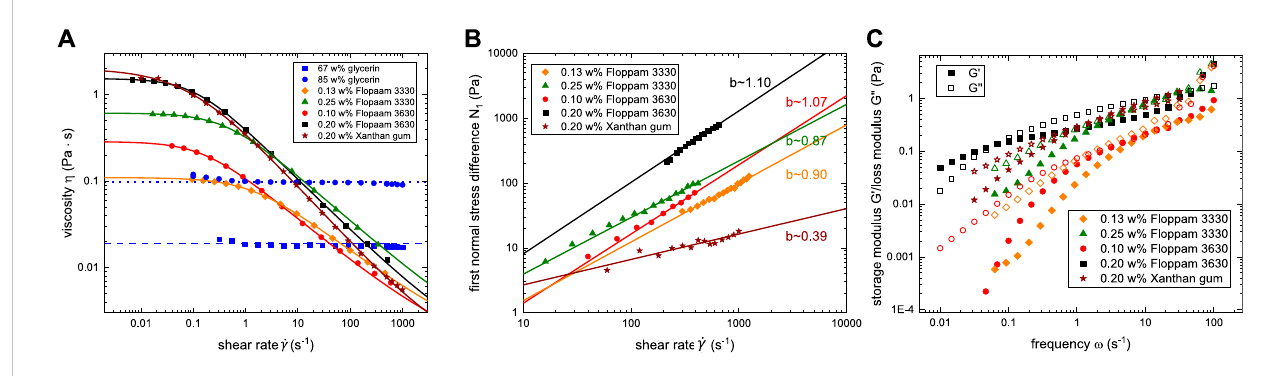
FIGURE 3 Full rheological characterization of (A) viscosity η ( _ γ ) , (B) fi rst normal stress difference N 1 ( _ γ ) , and (C) storage and loss modulus, G ′ ( ω ) and G ″ ( ω ) of the utilizedsolutions.Linesare fi tstotheCarreau – YasudamodelEq.1in (A) andtoapower-law N 1 ( _ γ ) (cid:3) A · _ γ b in (B) .The fi ttingparametersoftheCarreau – Yasuda model are given in Table 1.